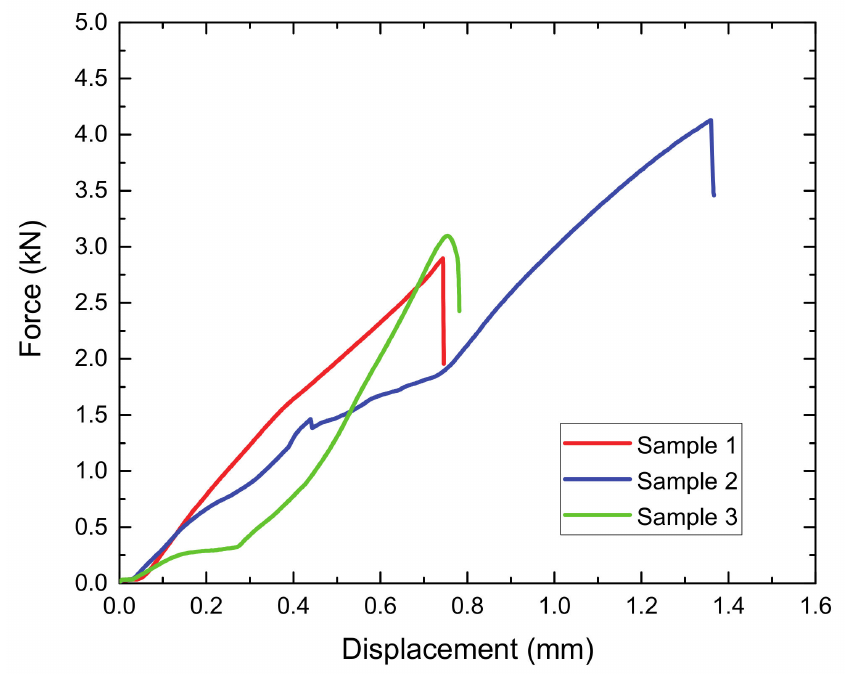
Figure 6. Load–displacement curve of the brazed joint shear